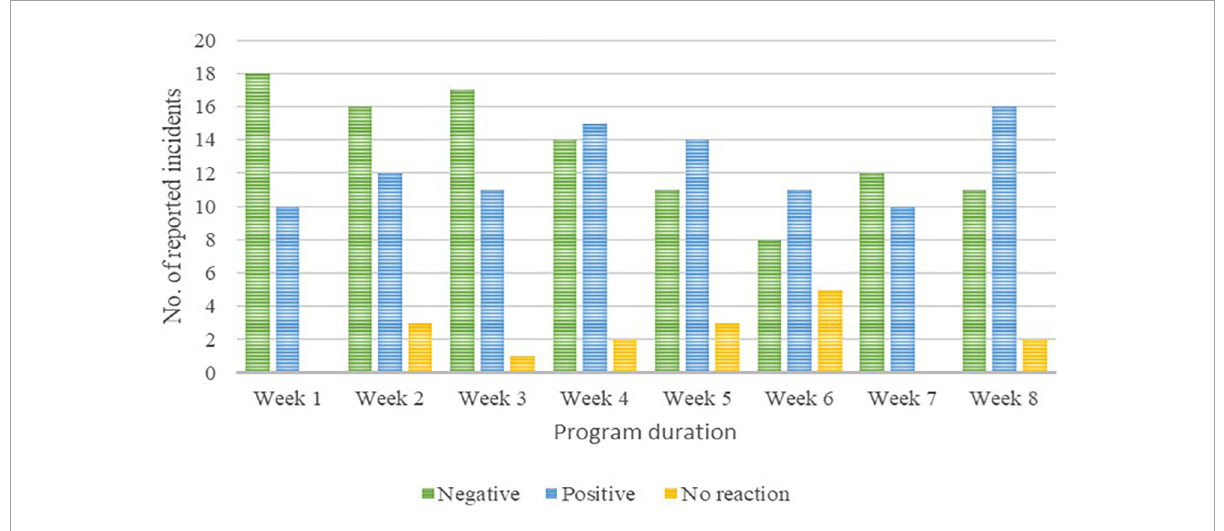
FIGURE1 Physical response of the body during the reported weekly incidents.